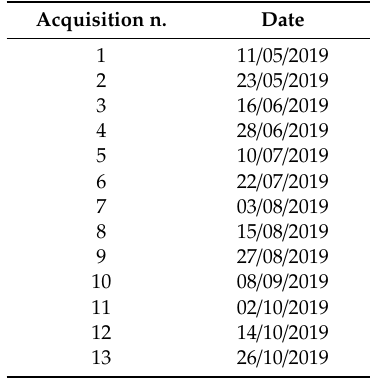
Table 5. Sentinel-1 ascending SAR dataset. Date format is day / month / year. Acquisition